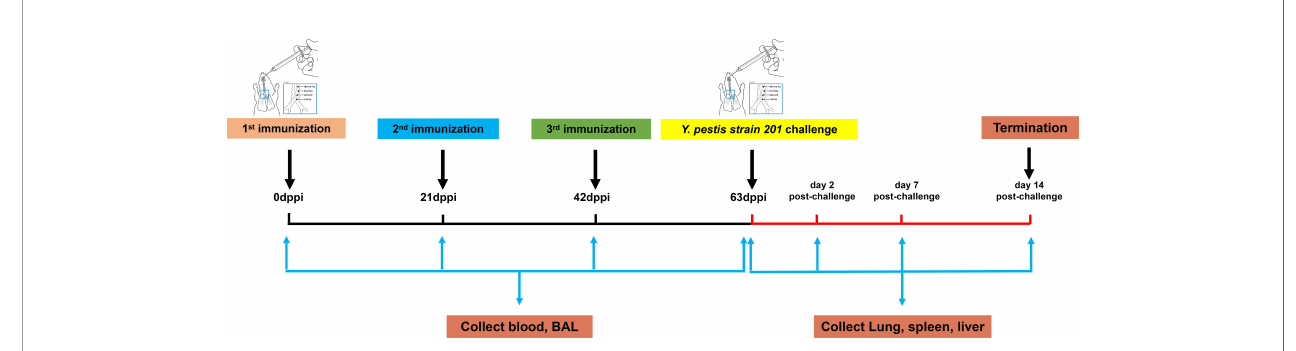
FIGURE 2 | Schema of the immunization protocol. BAL, bronchoalveolar lavage; dppi, days post-primary